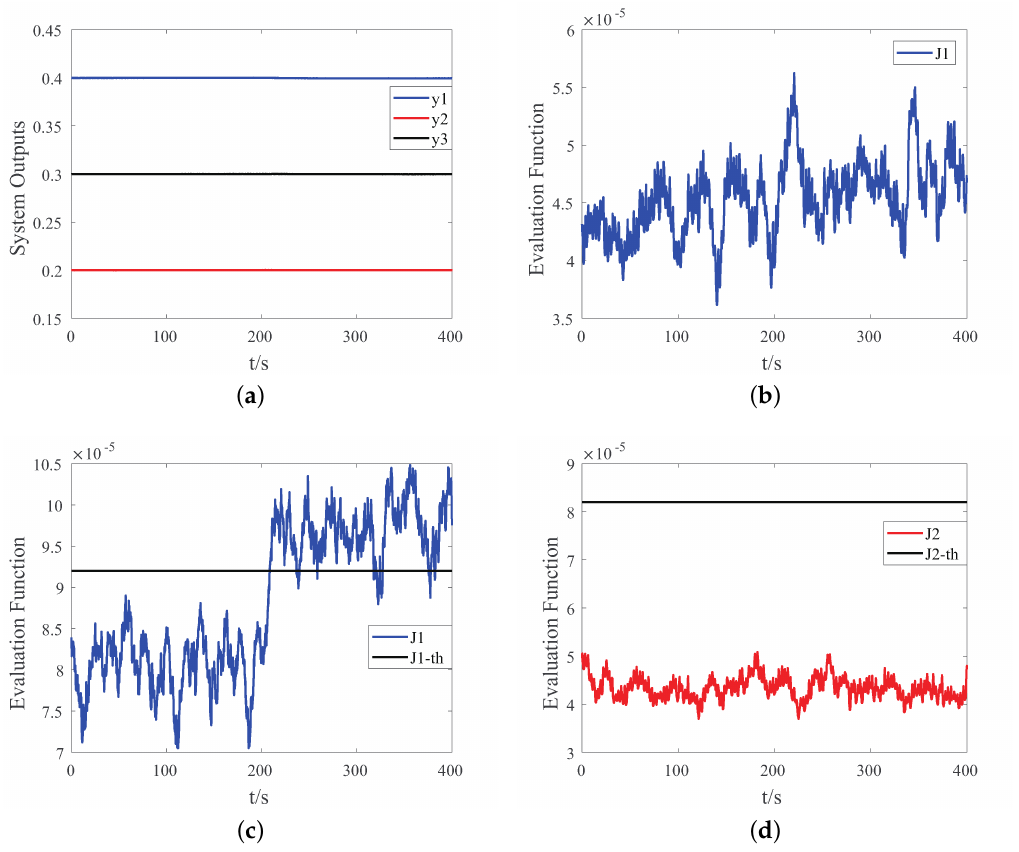
Figure 4. Simulation results of the system with fault mode i = 1 occurring at 200 s: ( a ) system outputs without auxiliary signals; ( b ) the evaluation function J [ 1 ] without auxiliary signals; ( c ) the